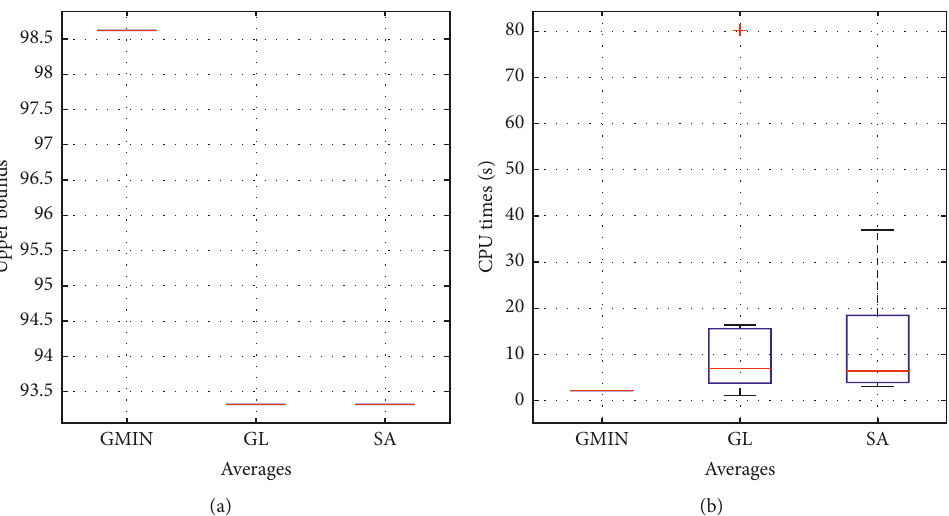
Figure 9: (a) Average upper bounds and (b) CPU times in seconds for the instance #11 in Table 1 while using a radial coverage value of